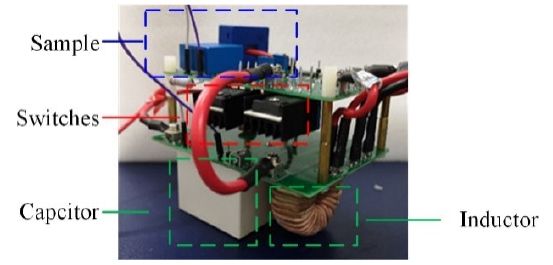
Figure 9. The image of the DCM inverter prototype.